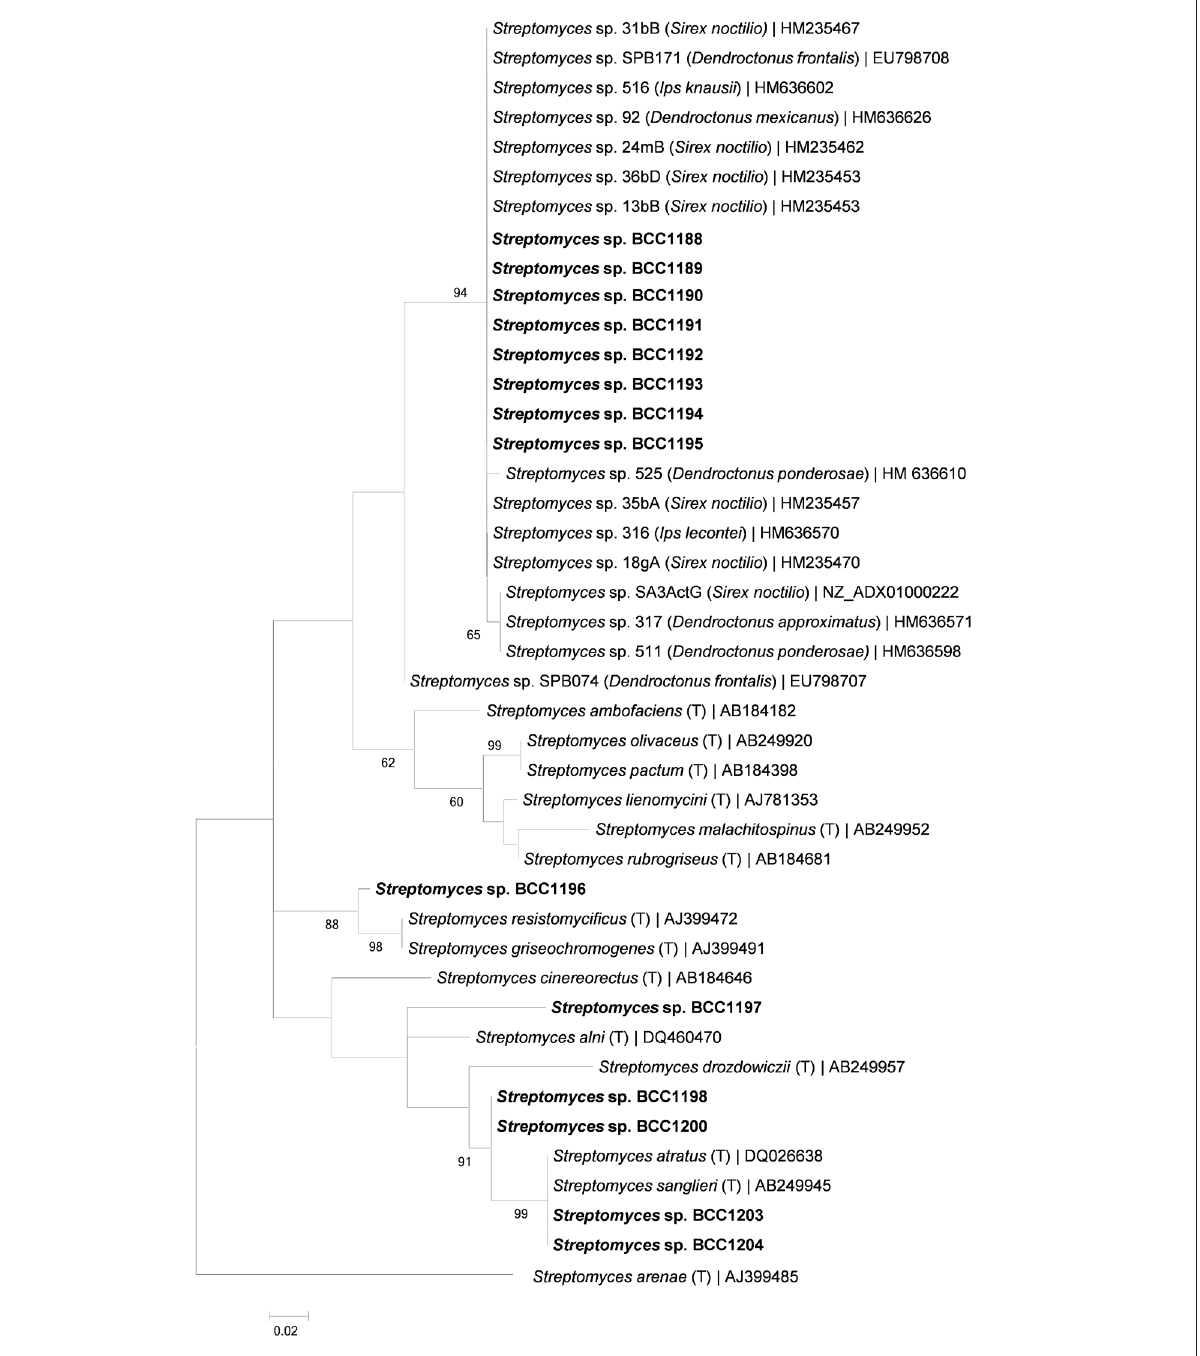
Figure 1: Maximum likelihood tree representing the 16S rRNA gene of all isolates from this study (in bold type) with closest matching type strains and isolates from other pine-infesting insects. Type strains are indicated by (T) and host names are included for sequences from Streptomyces spp. from pine-infesting insects. Streptomyces arenae was used as the